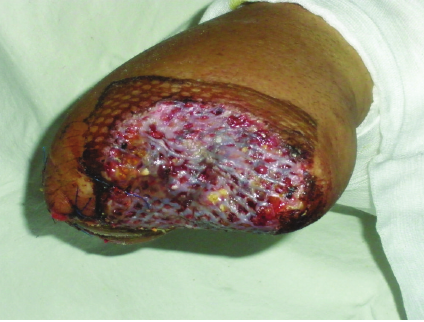
Figure 2: Eighth day after injury: initial signs of graft loss.